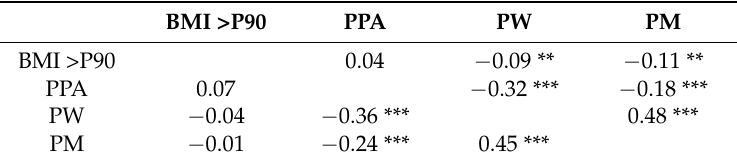
Table 2. Zero-order correlations (Spearman rank order